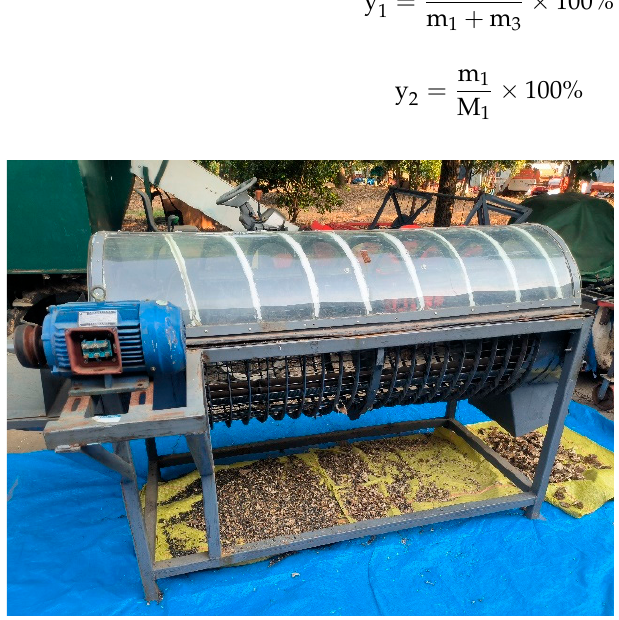
Figure 7. Physical image of the threshing test bench.